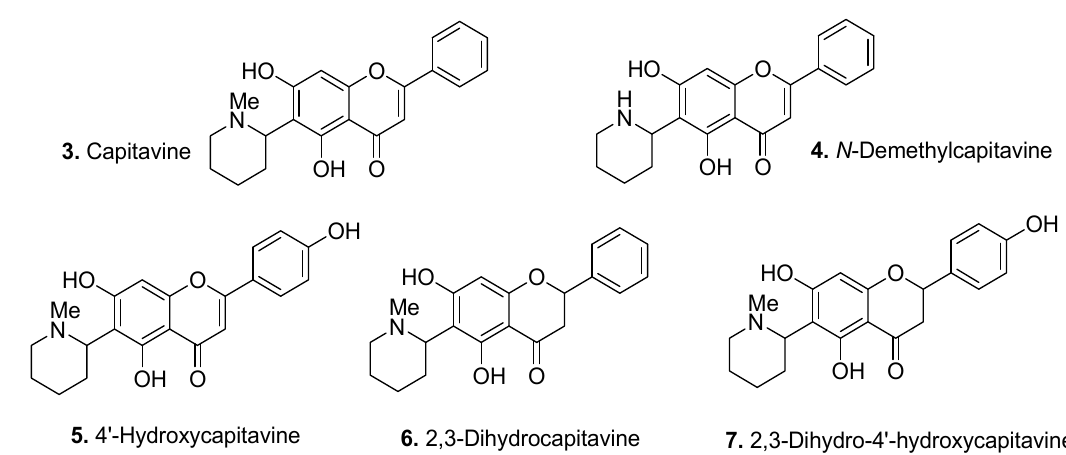
Figure 3. Capitavine ( 3 ) and capitavine derivatives ( 4–7 ).